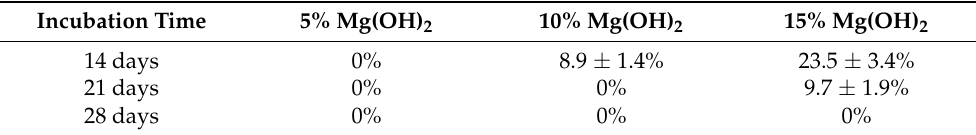
Table 2. Remaining Mg(OH) 2 in degrading microspheres (means ± SD, n = 3).